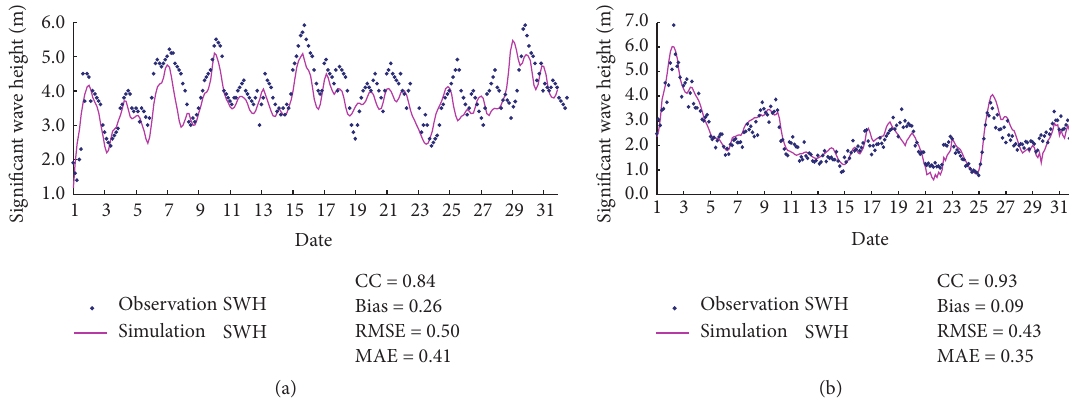
Figure 3: The simulated and observed significant wave height at Dongsha for year 2011, month 1 and month 10. Unit: